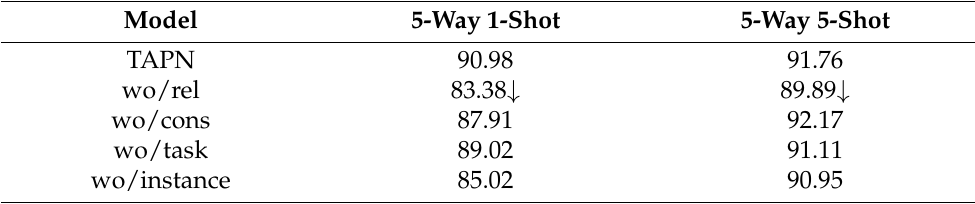
Table 6. Ablation study of TAPN for the 5-way 1-shot and 5-way 5-shot meta